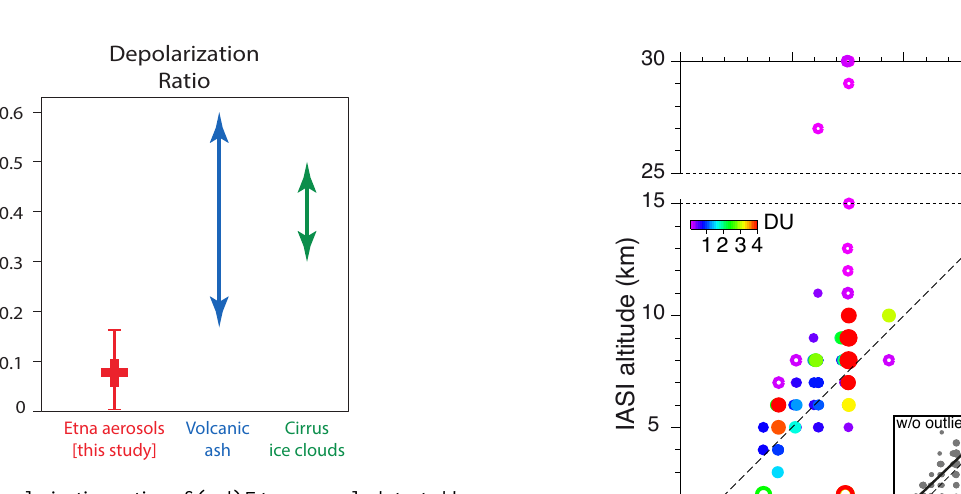
Figure 10. Depolarization ratios of (red) Etna aerosols detected by CALIOP in the 12–15h-old plume (Fig. 9, middle) in this study (cross indicates mean value while error bar includes both the range of variability and uncertainties), compared with the range of ratios recorded in the literature for (blue) volcanic ash (Ansmann et al., 2011; Wiegner et al., 2012; Groß et al., 2012; Derimian et al., 2012; Winker et al., 2012; Pappalardo et al., 2013) and (green) cirrus ice clouds (Sassen and Benson, 2001; Sassen, 2005; Seifert et al., 2011).